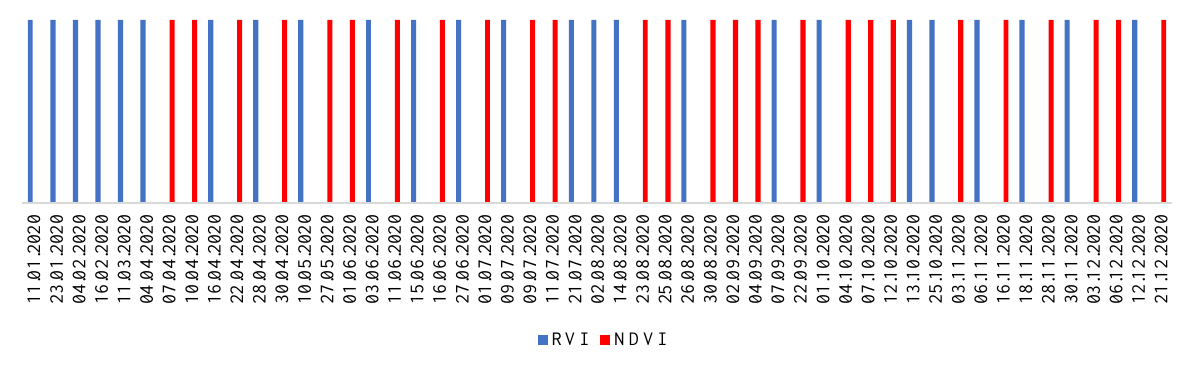
Figure 3 . Sentinel 1/2 image acquisitions in 2020.